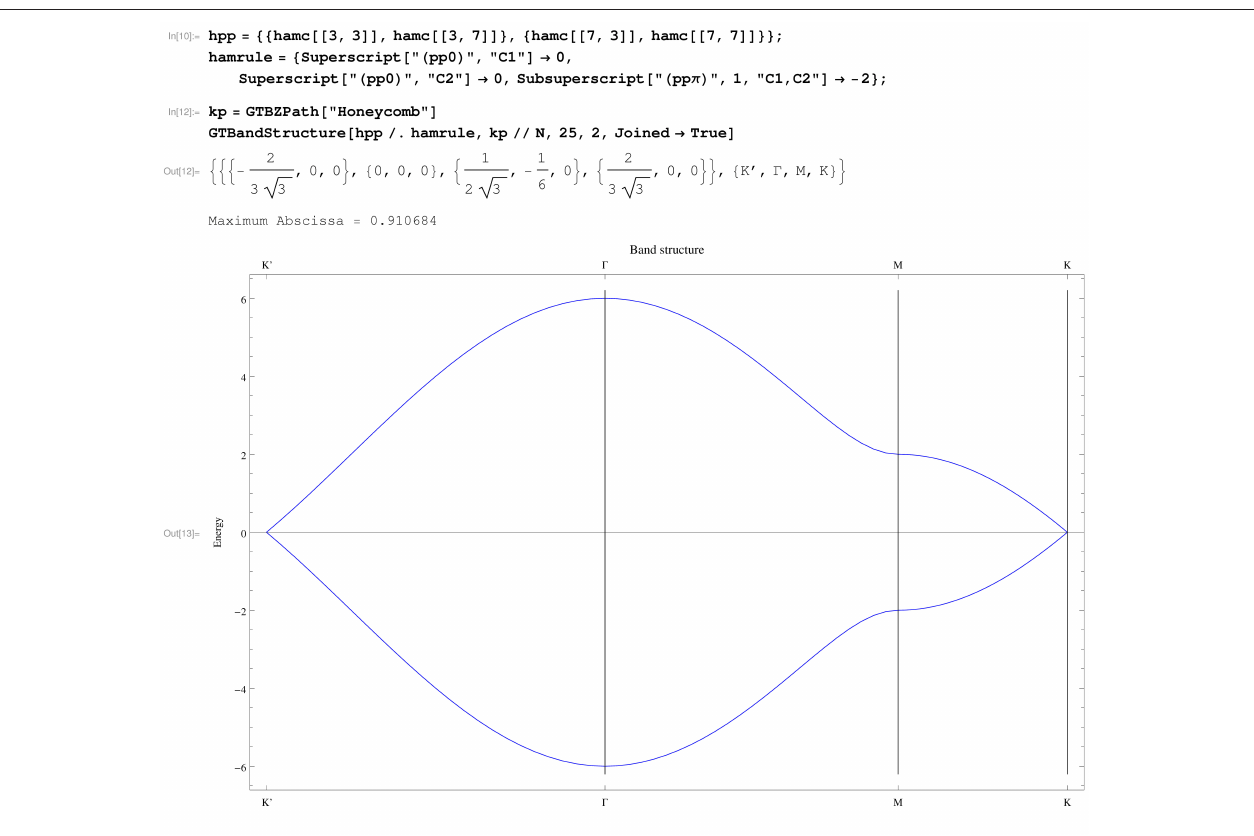
FIGURE 7 | Band structure calculation for